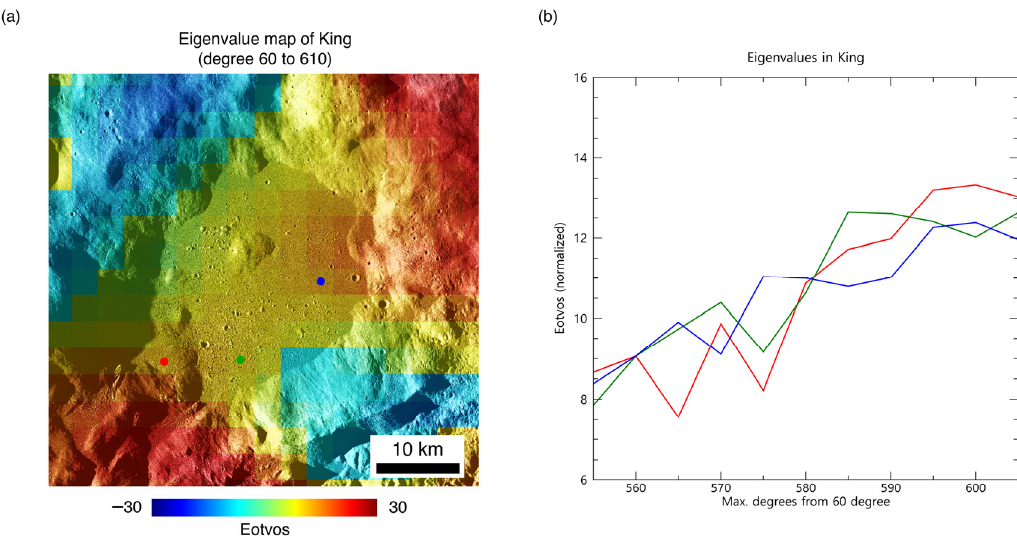
Figure 6. Eigenvalues map and eigenvalue variation of King pit region. ( a ) The King pond area is not a negative feature, but it cannot be said to be a strong positive feature. Only three points show mass deficit signals. ( b ) All three points are regions where pits are clustered, showing a positive trend. The graph is normalized at the 560th degrees to easily understand the trend change.